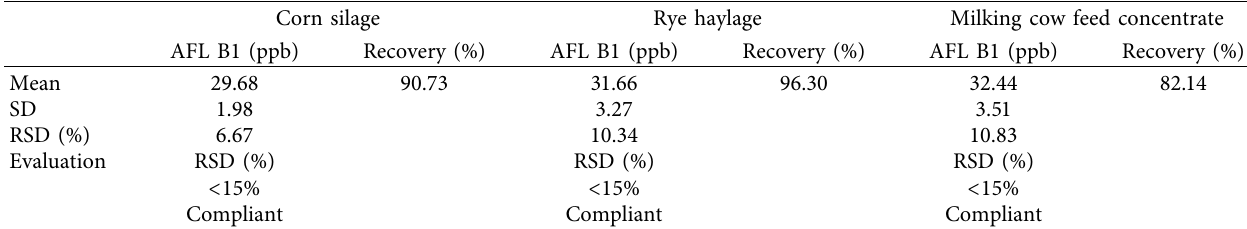
Table 3: Accuracy and recovery calculation of AFL B1 for fermented forages and mixed feed n � 8.